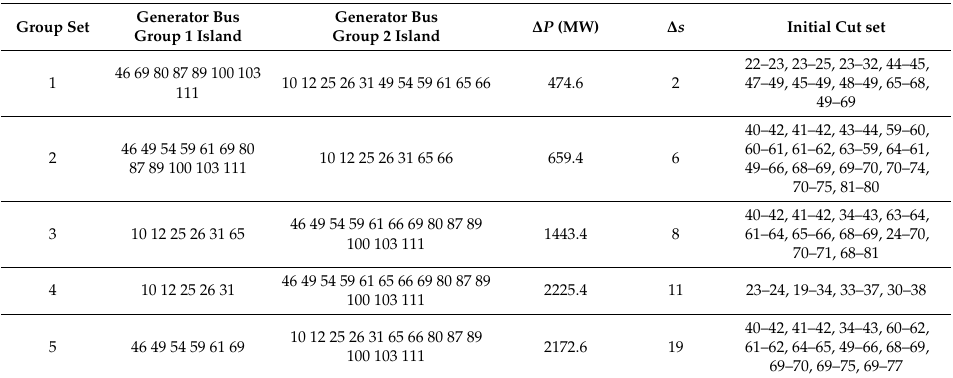
Table 5. Heuristic technique for IEEE 118 test